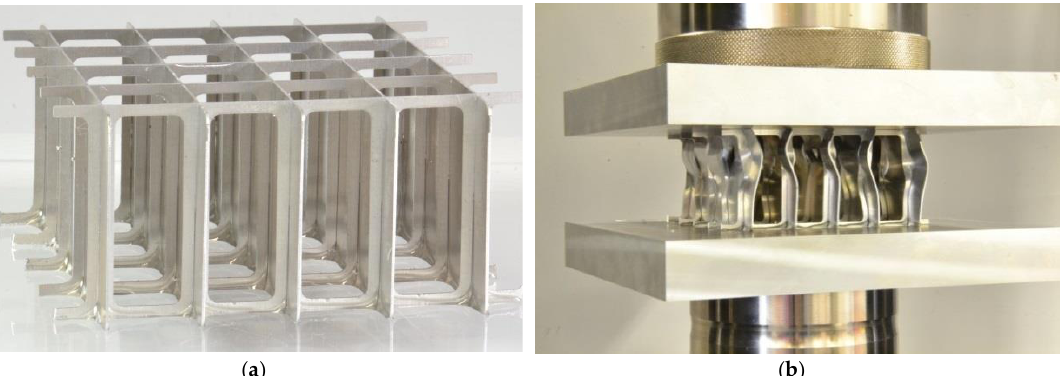
Figure 11. ( a ) Specimen ( B / H = 0.63) for investigation of deformation behaviour; ( b ) buckling failure of honeycomb core structure. Table 4. Results of compression tests of honeycomb core structure